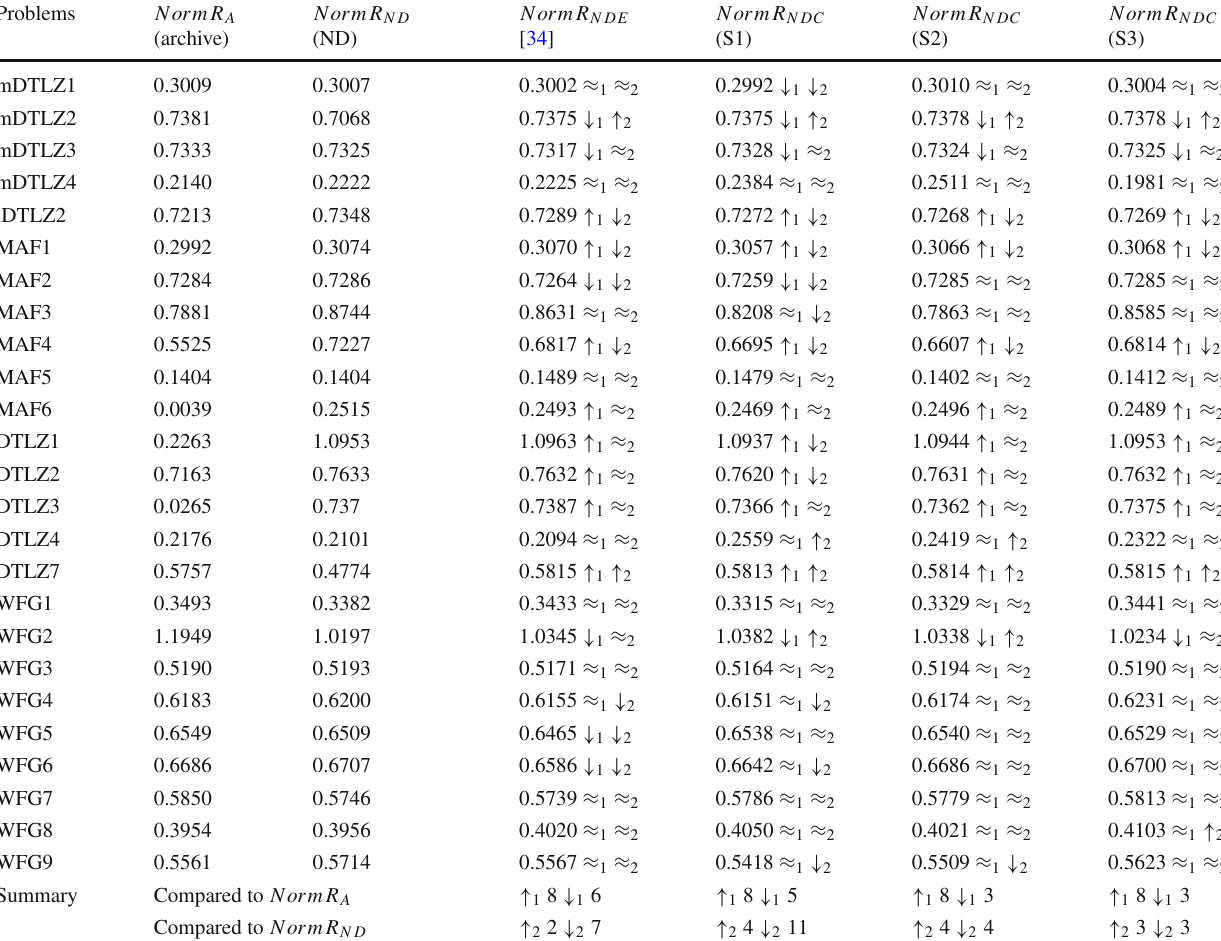
Table 3 Median HV performance in test problems with 3 objective across 29 independent runs